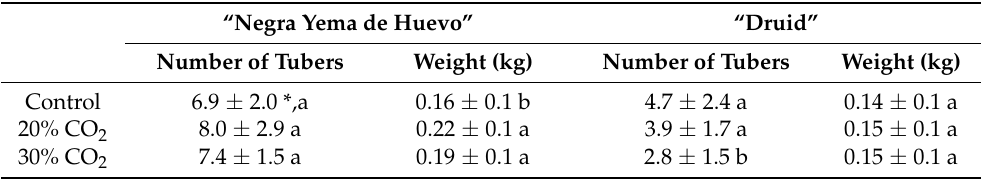
Table 3. Effects of 10-day treatment with 30% CO 2 , 20% O 2 , and 50% N 2 controlled atmosphere on the germination capacity (number of tubers per plant and average potato